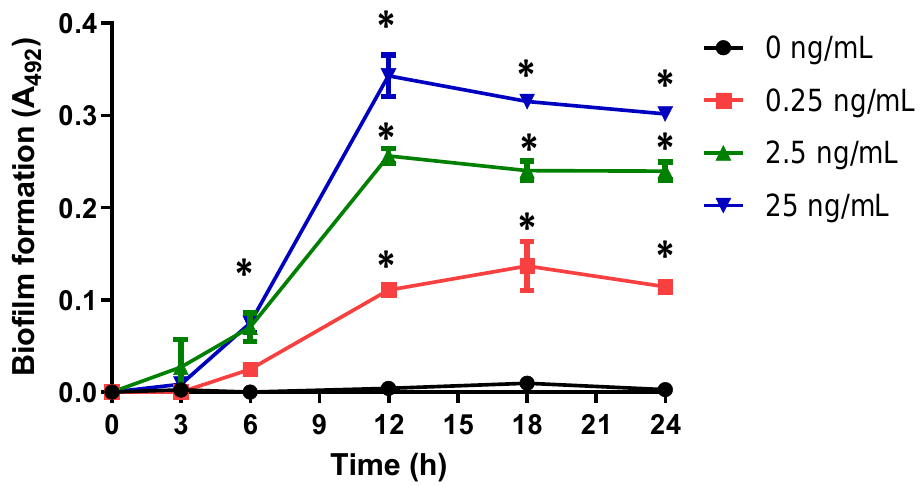
Figure 2. Kinetics of biofilm formation with different concentrations of proteinase-3 in isolate 54HS. Proteinase-3 was added at different concentrations from the beginning of the biofilm formation kinetics. At different times, the biofilm formation was determined by the method of Christensen et al. in isolate 54HS (healthy skin). Asterisk * indicates a significant difference ( p < 0.05) concerning the control (bacteria without proteinase-3). The statistical analysis was performed using a one-way ANOVA with Tukey’s test.